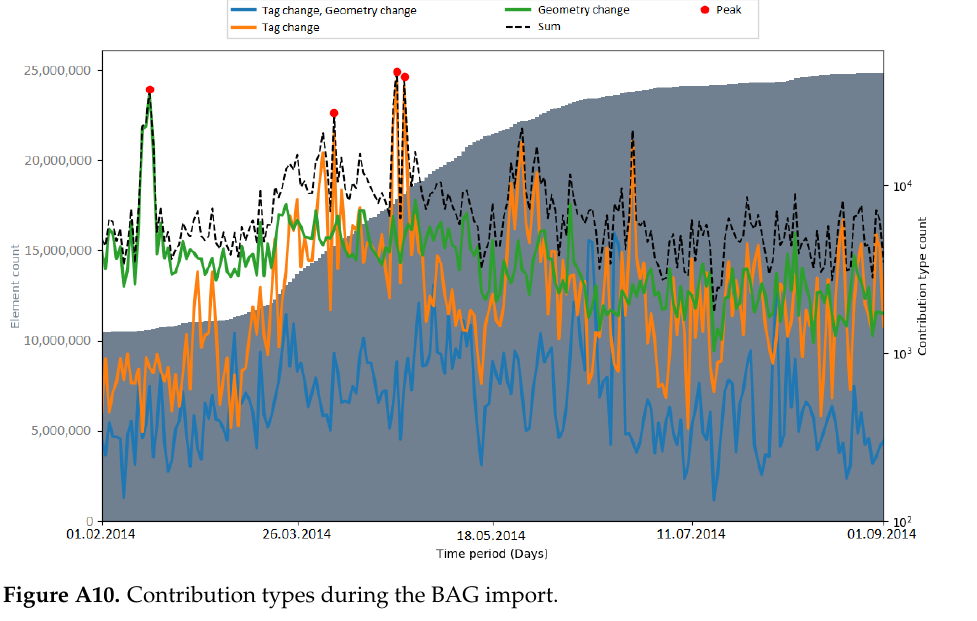
Figure A10. Contribution types during the BAG import.